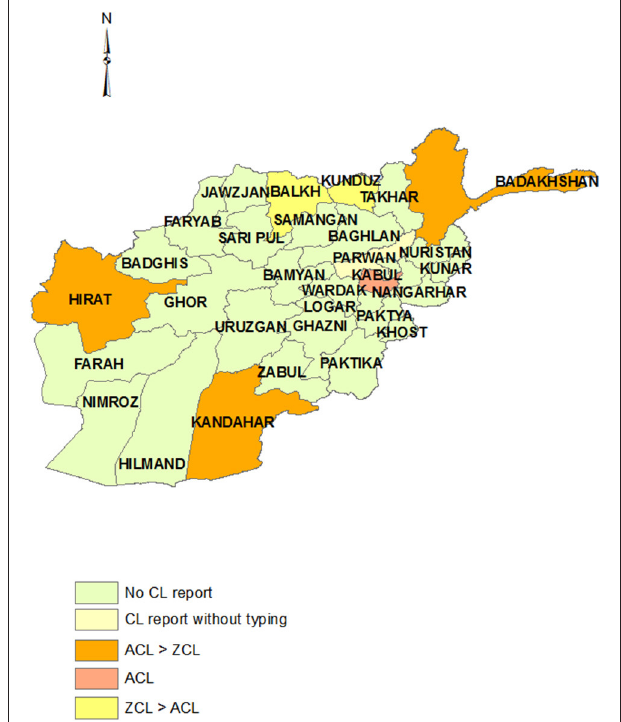
FIGURE 5 | Distribution of CL types in Pakistan. The Khyber Pakhtunkhwa province was assumed the areas under N.W.F.P and F.A.T.A regions. FIGURE 6 | Distribution of CL types in